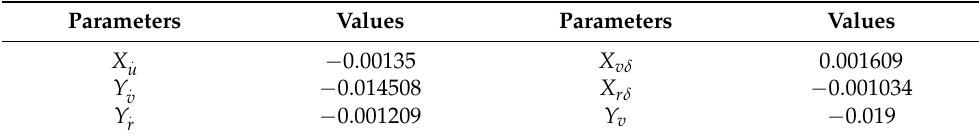
Table 2. Hydrodynamic